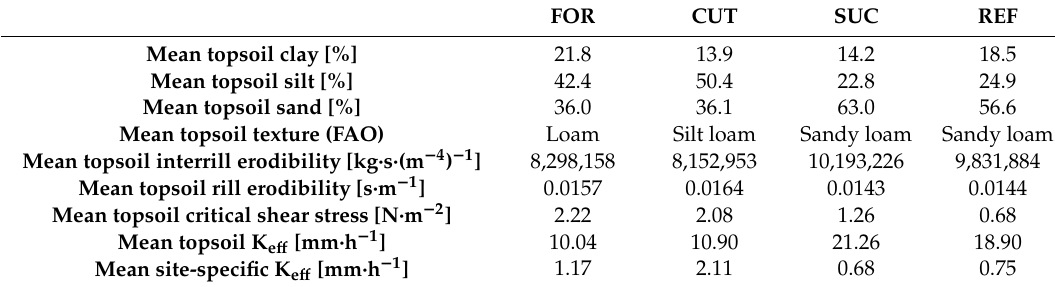
Table 8. Mean topsoil texture, erodibilities, critical shear stress and e ff ective hydraulic conductivity (K e ff ) and mean site-specific e ff ective hydraulic conductivity of every sub-area; (FOR)ested, (CUT)-down, (SUC)cession, (REF)orested.